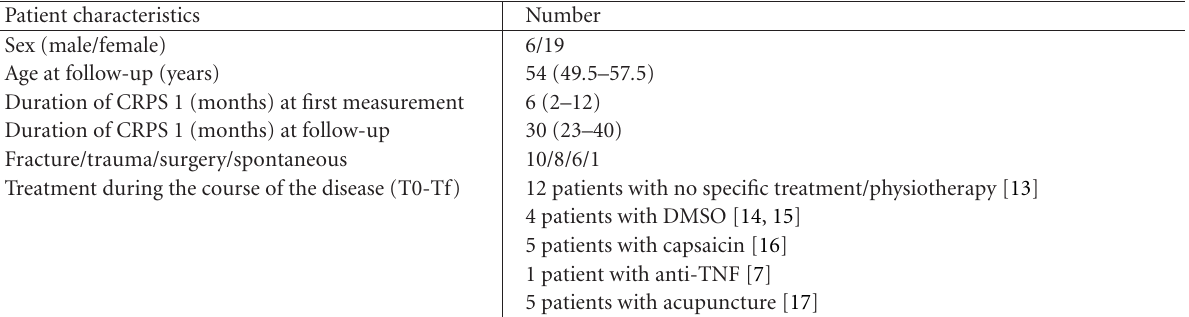
Table 1. Demographic data. Data are presented as median ± interquartile range. Two patients participated in 2 studies. References: literature on reported e ff ects in CRPS